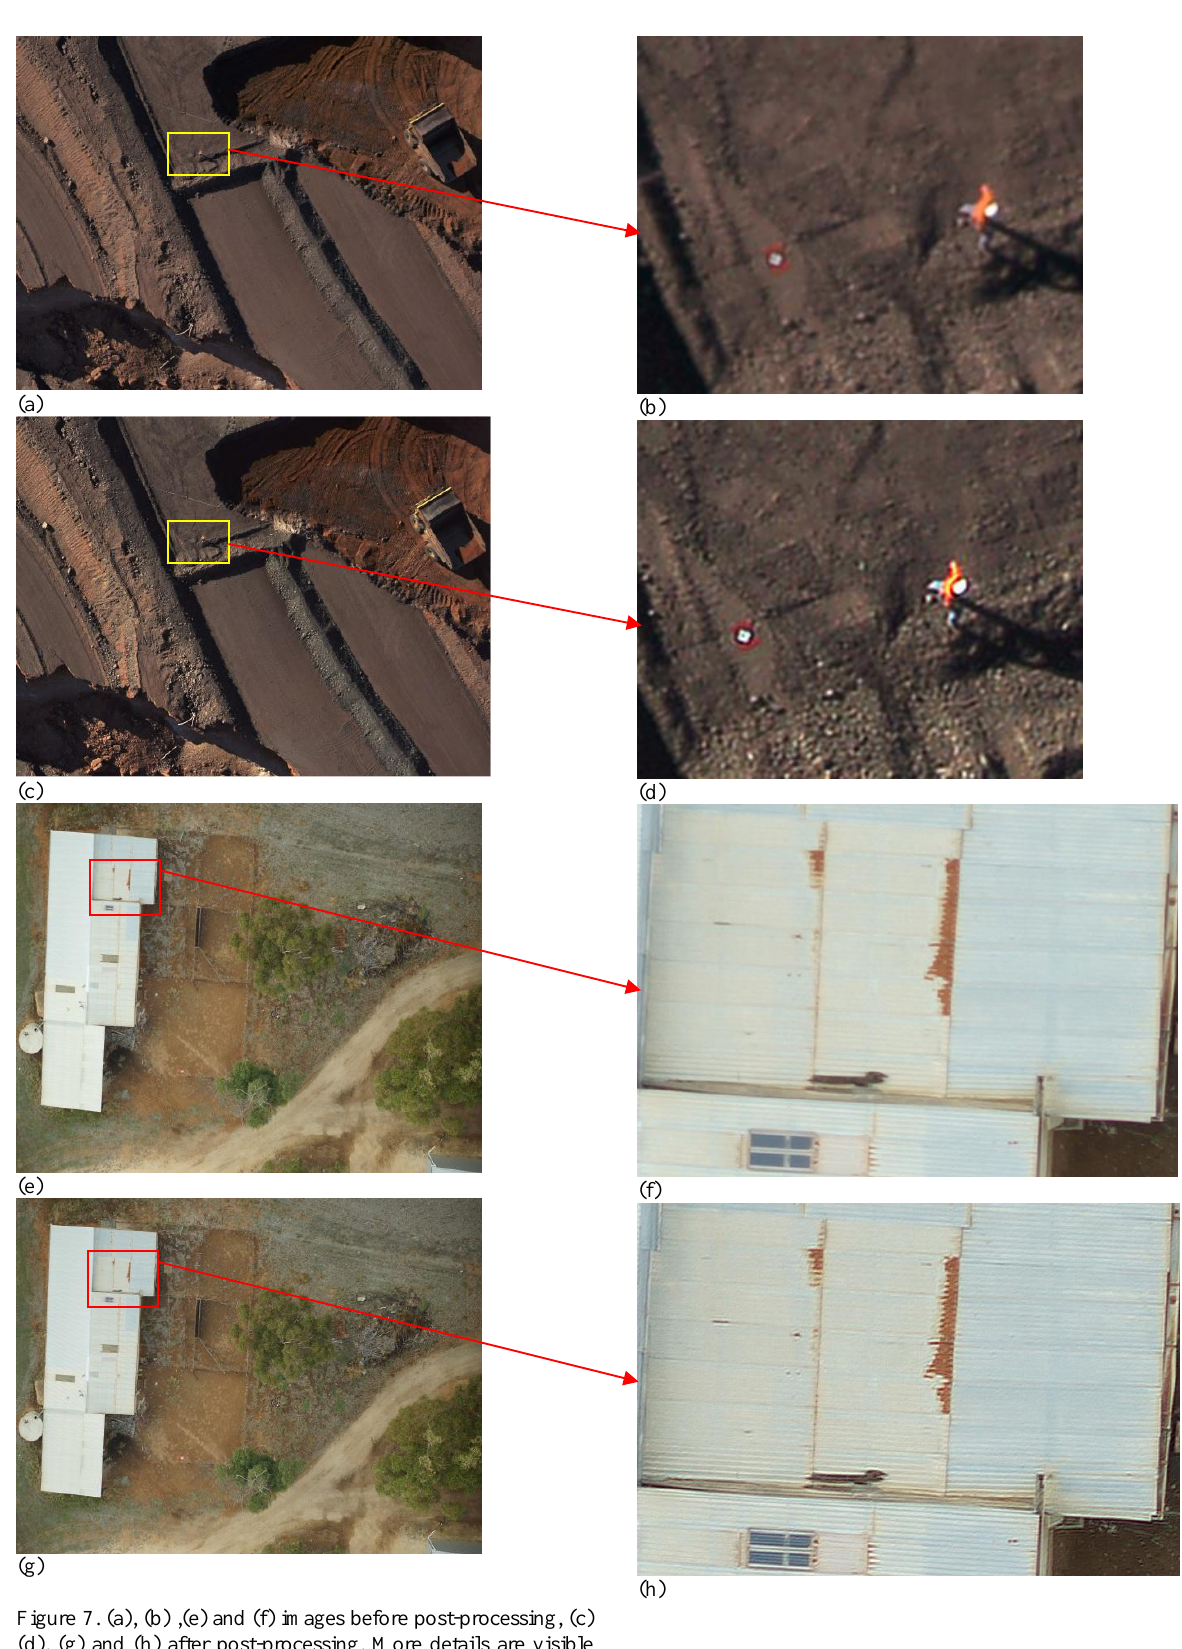
Figure 7. (a), (b) ,(e) and (f) images before post-processing, (c) (d), (g) and (h) after post-processing. More details are visible after